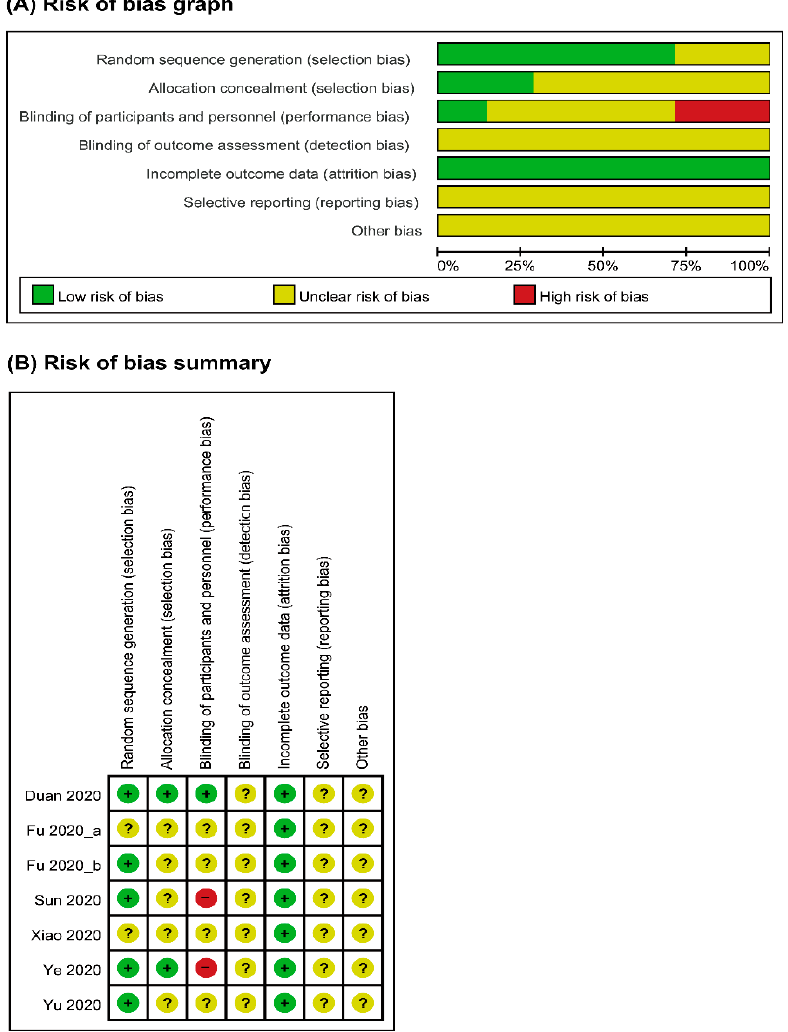
Figure 2. Risks of bias. ( A ) Risks of bias of the included studies. The authors reviewed each item’s risk of bias for each included study. ( B ) Risks of bias of individual studies. + : low risk of bias; − : high risk of bias; ?: unclear risk of bias.